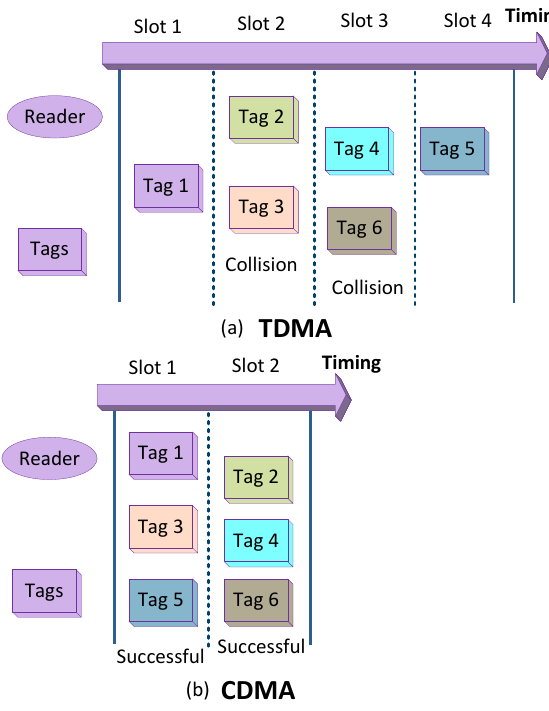
Figure 26. CDMA compared with TDMA in